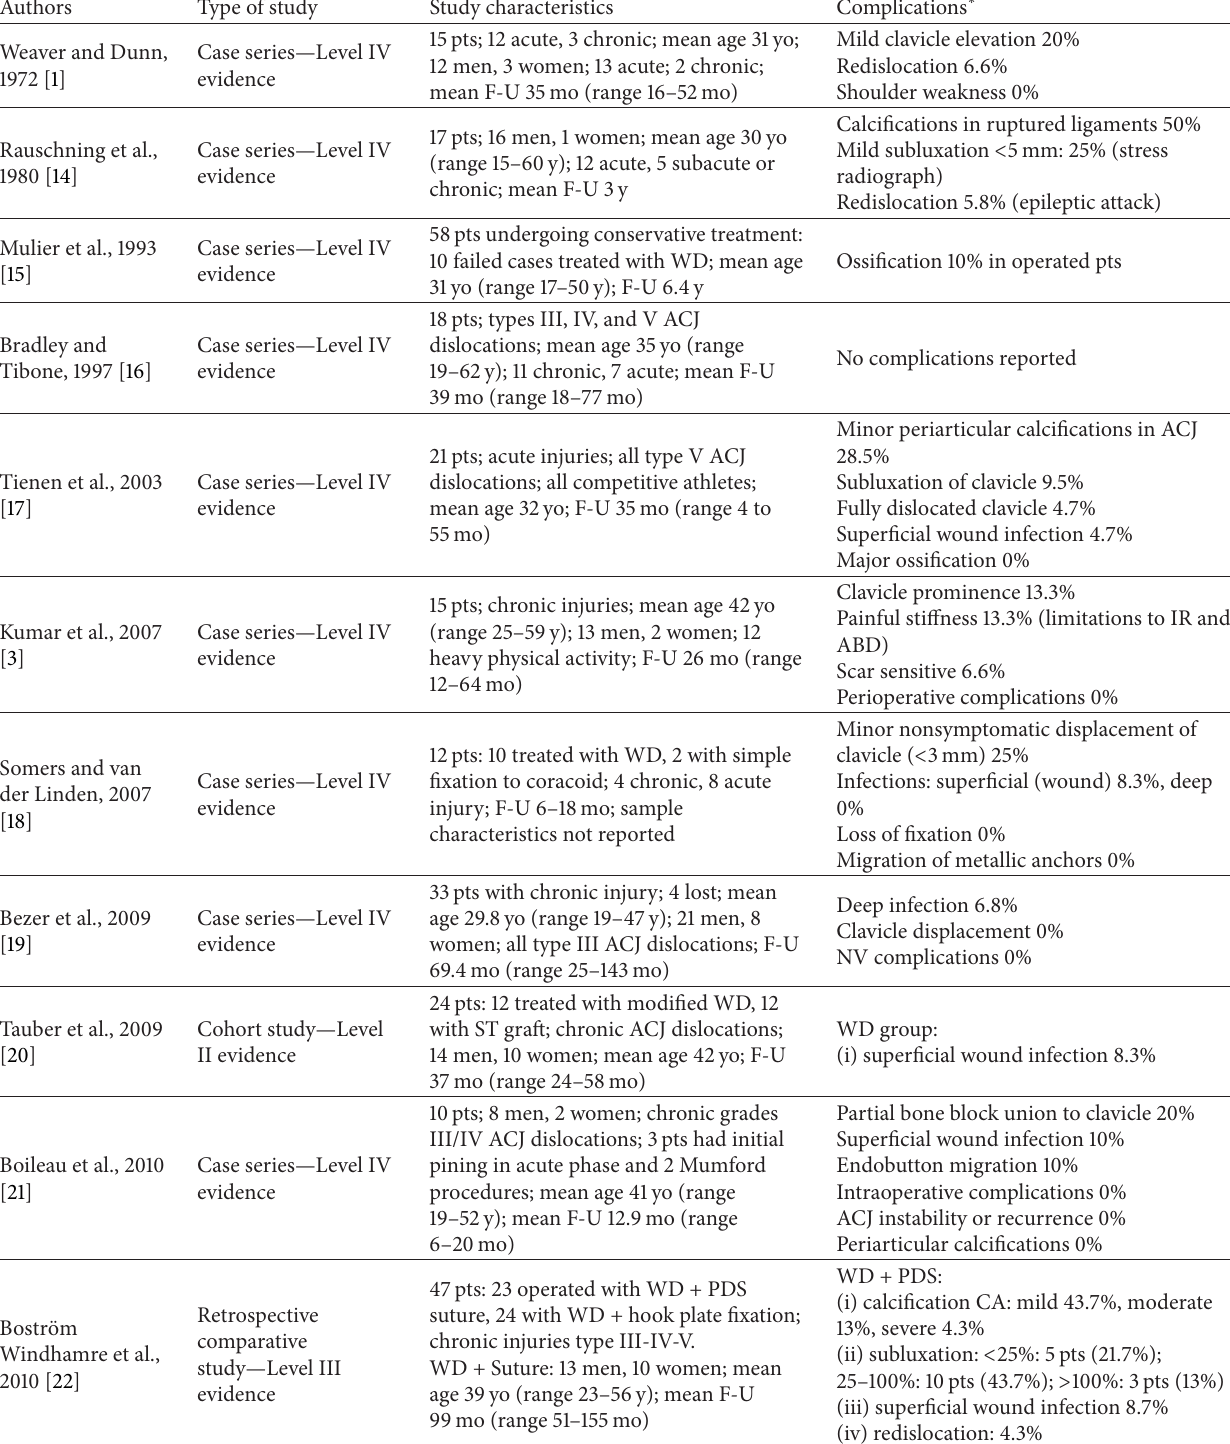
Table 1: Summary of studies reporting complications with Weaver-Dunn’s procedure for acromioclavicular dislocation.